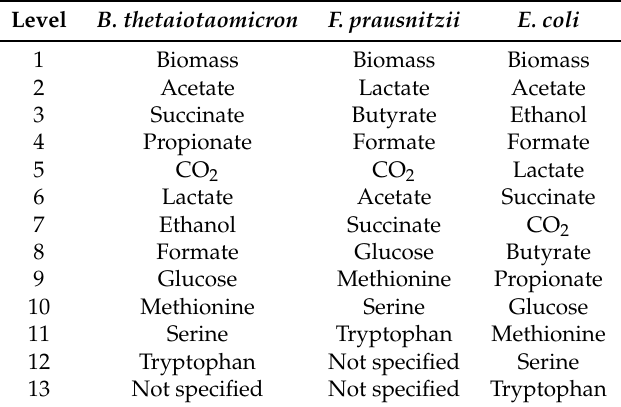
Table 2. Lexicographic optimization